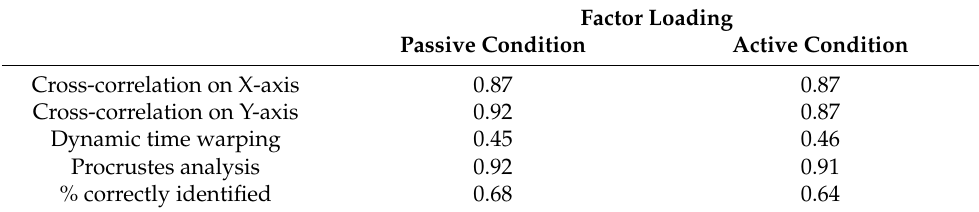
Table 3. Factor loadings of the reproduction and identification parameters.